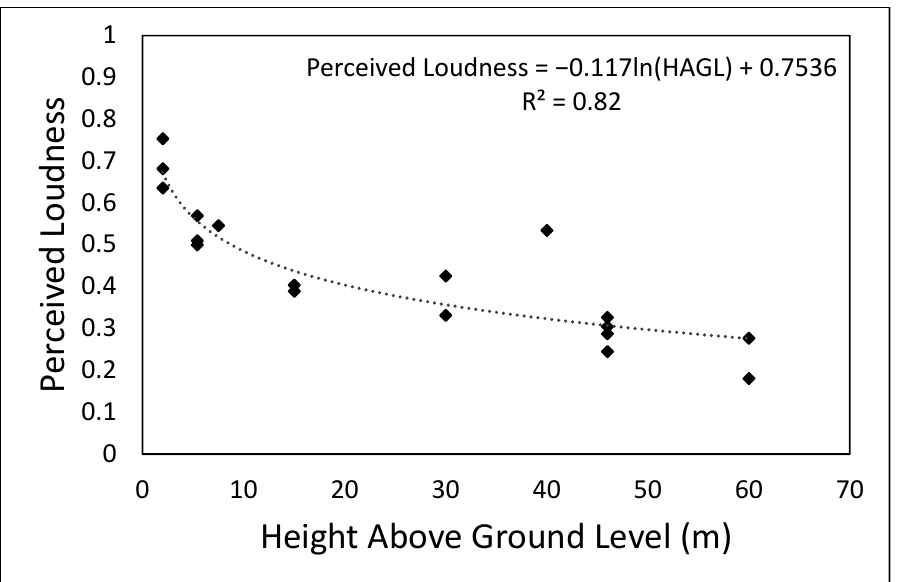
Figure 3 . Perceived loudness vs. height above ground level of the unmanned aerial vehicles under investigation during flyover operation.